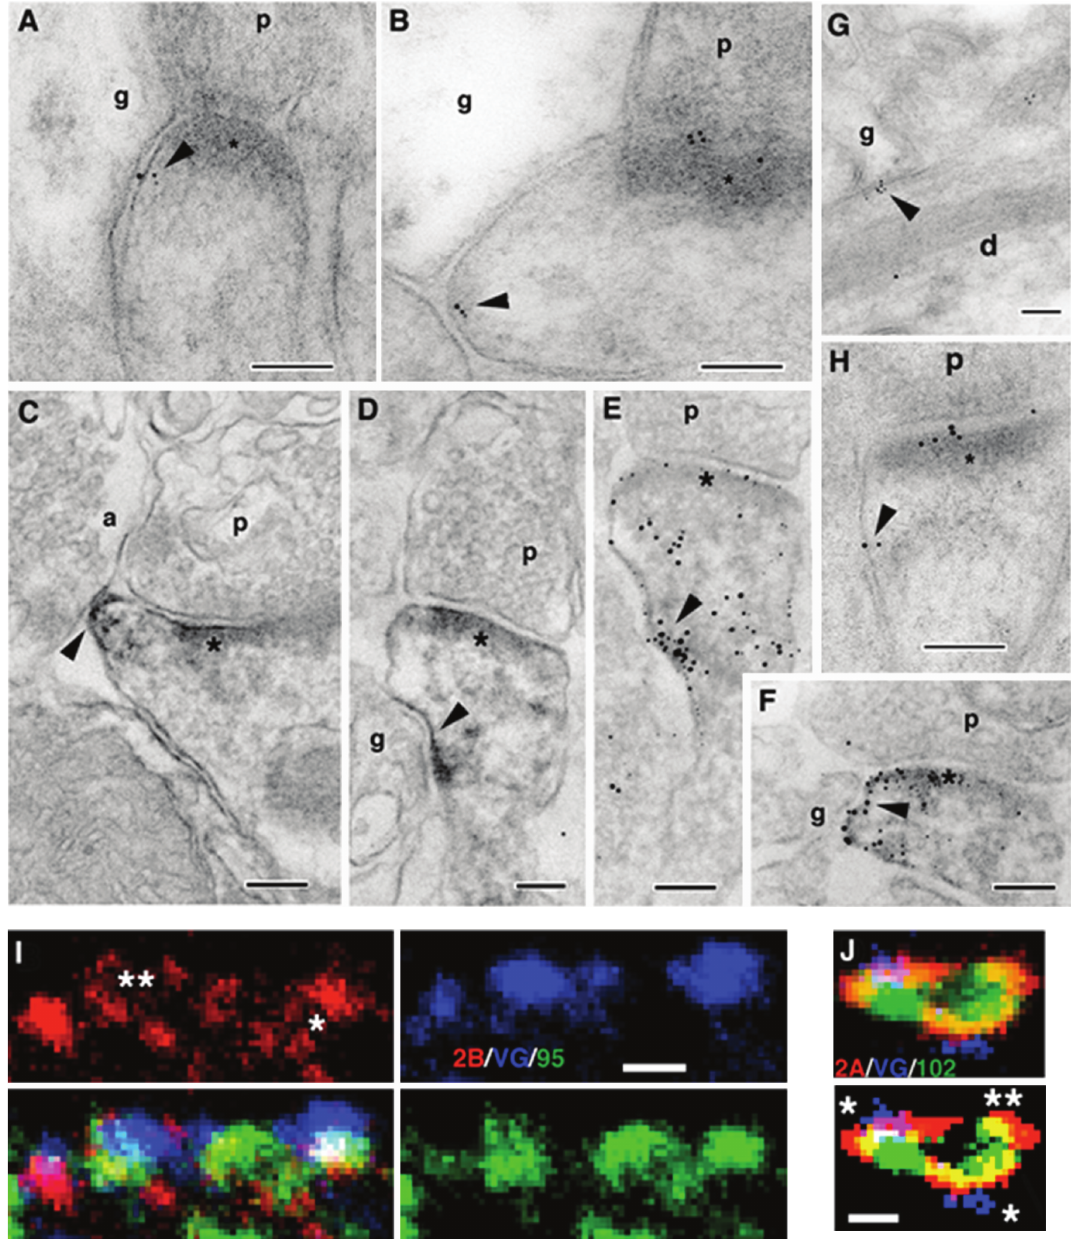
Figure 3: Extrasynaptic NMDARs (NR1 antibody; arrowheads) in the CA1 stratum radiatum of the adult hippocampus (A–H) using immunogold (AB,G,H) or EM immunoperoxidase/DAB (C–F: E and F were processed further with silver/gold toning), and immunofluorescence colocalization of NR2B/VGLUT1/PSD-95/93 (I) or NR2A/VGLUT1/SAP102 (J) in cultured hippocampal neurons. For A–H, extrasynaptic NMDARs can be seen on postsynaptic spines (A–F, H) or dendrites (G; d) adjacent to other processes, including glia (g) and various neuronal processes (see text for details). a: axon terminal; p: presynaptic terminal; asterisk: postsynaptic density. In I, NR2B labeling (red) forms in a perisynaptic ring ( ∗∗ ) around synaptic PSD-95/93 (green) and the terminal (labeled with the presynaptic marker, VGLUT1 [blue]) and forms a ring of three puncta around an extrasynaptic punctum of PSD-95/93 ( ∗ ). In J, this is an enlarged region found along a thin, distal dendrite. Note how NR2A labeling (red) is spread in the perisynaptic regions surrounding two synapses ( ∗ ): SAP102 (green) forms around the enlargement in conjunction with both the synaptic and extrasynaptic ( ∗∗ ) NR2A; the bottom image is a high contrast version of the top one. Scale bars are 100nm for A–H and 500 nm for I, J. Reprinted from parts of Figures 2, 5, and 6 from Petralia et al.